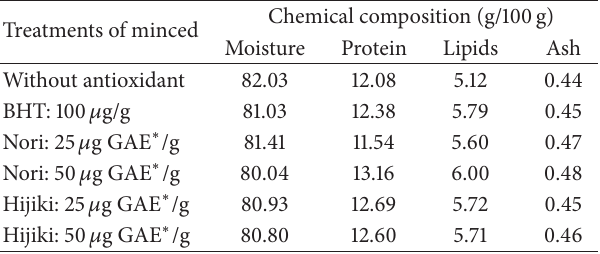
Table 1: Proximate chemical composition of the minced